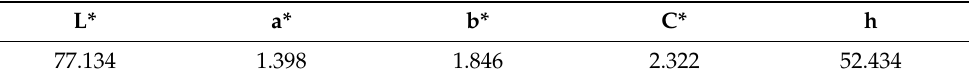
Table 3. CIELAB colour space coordinates of the Ni/Y 2 O 3 nanocomposite coating obtained with the CIELAB analysis.